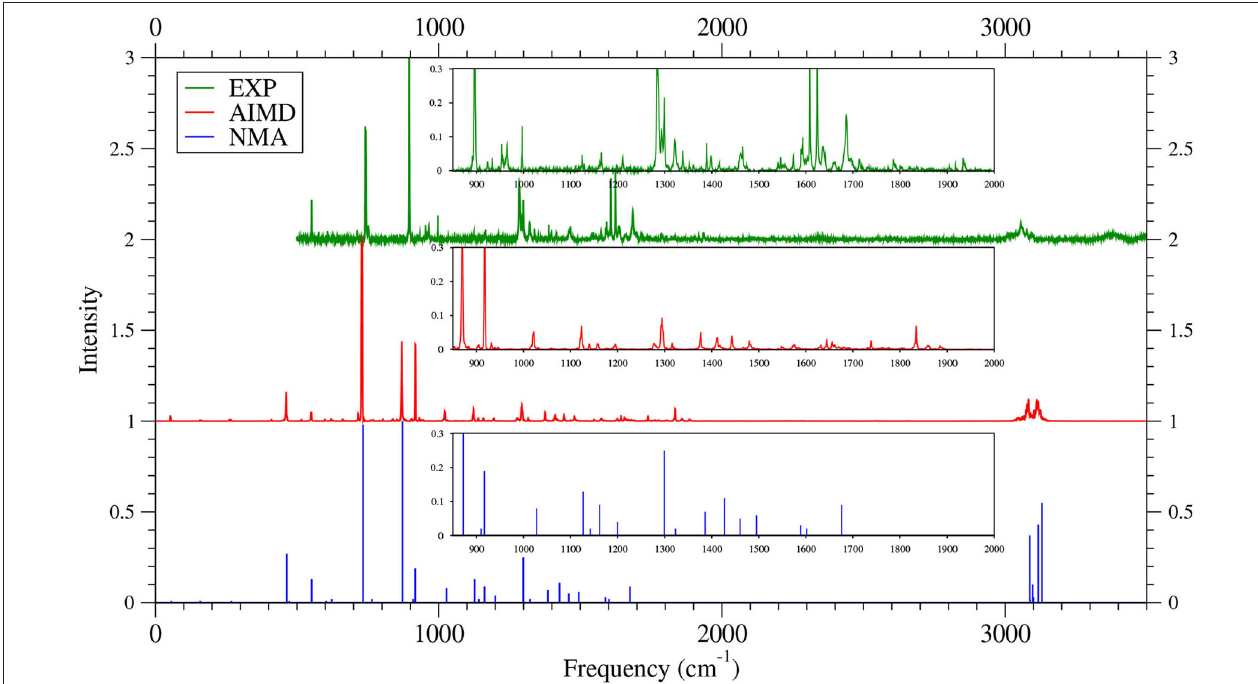
FIGURE 8 | IR spectra of 4-acene, obtained with the TAO-AIMD simulations at 300 K and GS-NMA, calculated by TAO-LDA. Experimental (EXP) data (Hudgins and Sandford, 1998a; Boersma et al., 2014; Bauschlicher et al., 2018 ; Mattioda et al., unpublished) are included for comparison. The IR spectra are normalized to have a maximum intensity of one and, for clarity, are vertically offset from each other by the same value. Subfigures show the IR spectra in the 850–2,000 cm − 1 range.